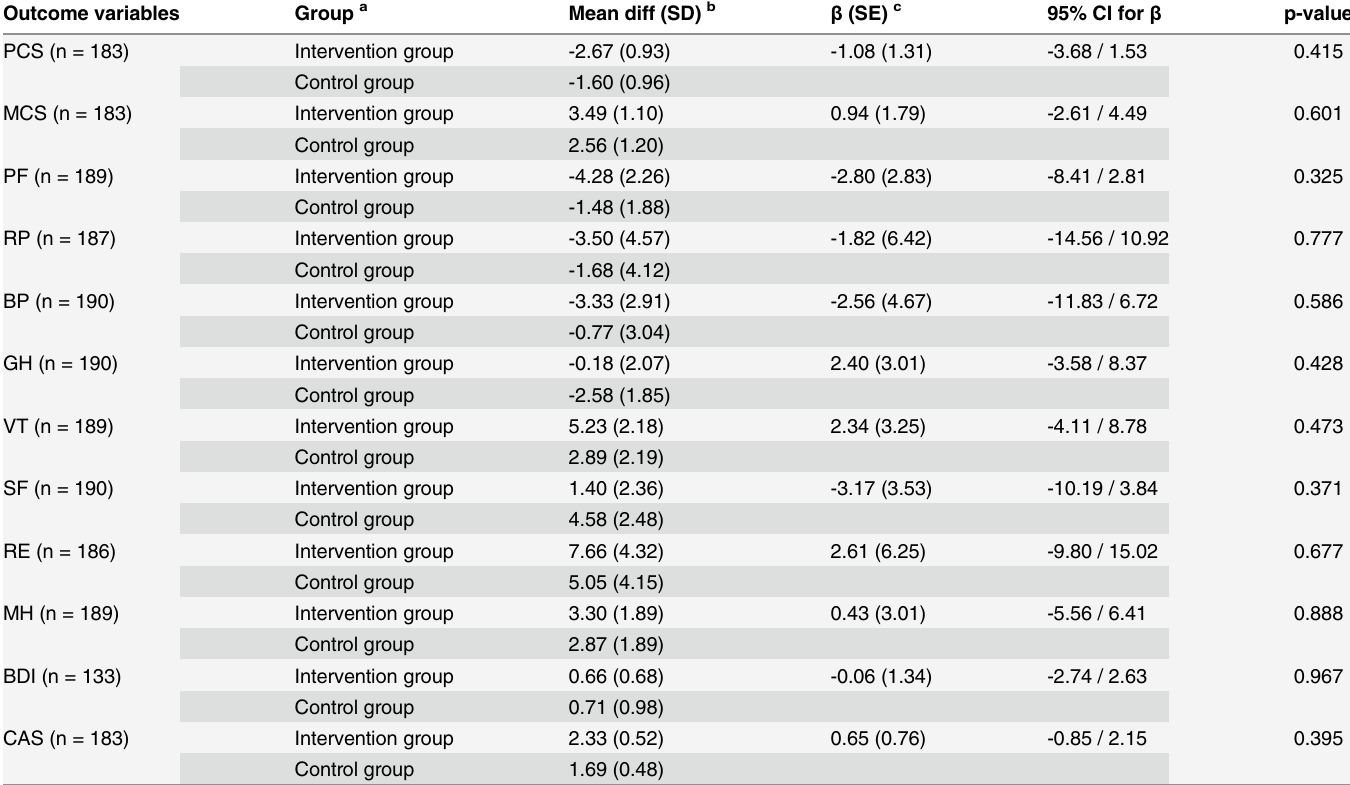
Table 4. Multiple linear regression analyses (robust variance estimates) to detect intervention effects regarding health, symptoms of depression and perceived control for both patients and partners. Outcome